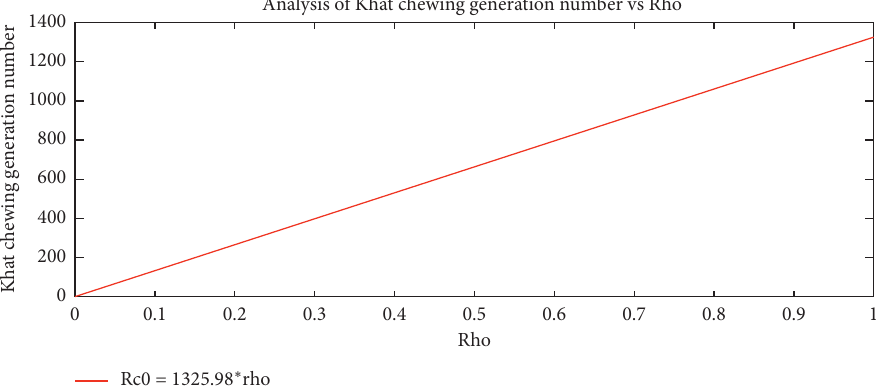
Figure 3: The Khat-chewing generation number increases as the value of ρ